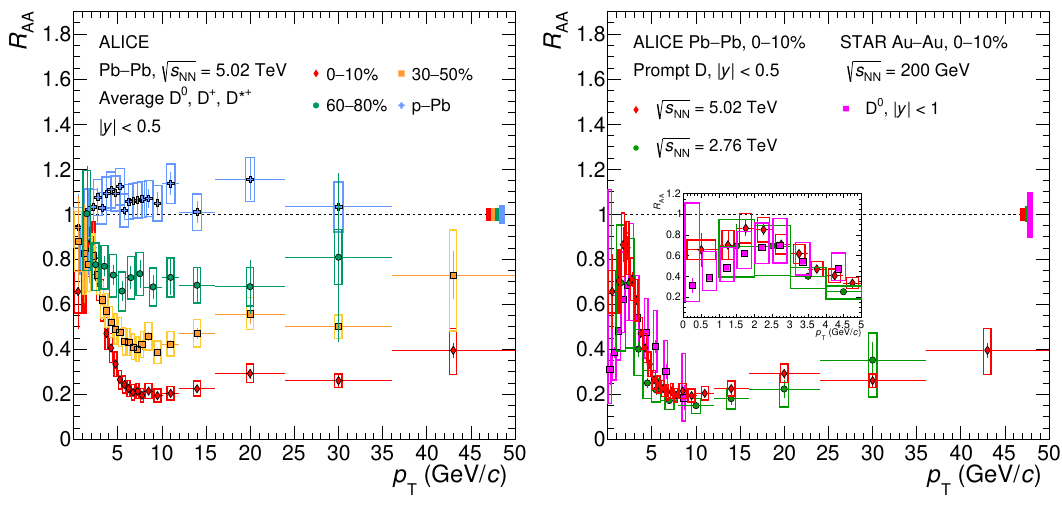
Figure 7 . Left panel: prompt D-meson R AA (average of D 0 , D + , and D ∗ + ) as a function of √ p T measured in Pb–Pb collisions at s = 5 . 02 TeV (2018 data sample) in the 0–10% and 30– NN 50% centrality classes compared with published results in the 60–80% centrality class (2015 data sample) [30] and in p–Pb collisions at the same centre-of-mass energy [33]. Statistical (bars), systematic (boxes), and normalisation (shaded box around unity) uncertainties are shown. Right √ panel: prompt D-meson R AA in the 10% most central Pb–Pb collisions at s = 5.02 TeV and NN 2.76 TeV [29] compared to the D 0 R AA measured by the STAR collaboration in Au–Au collisions √ at s = 200 GeV NN